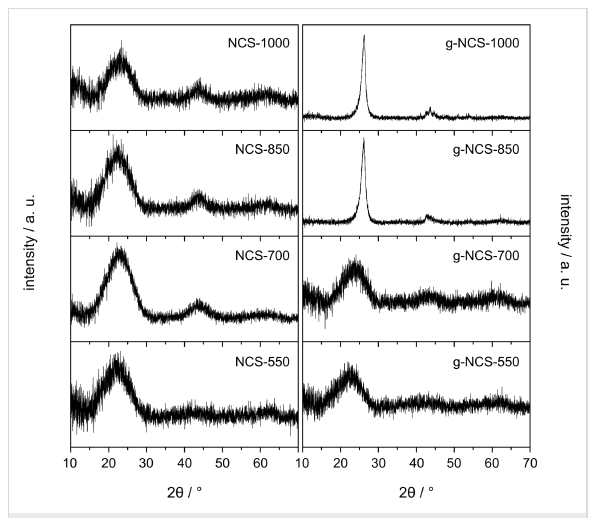
Figure 4: X-ray diffraction patterns of the NCS and g-NCS catalyst series.